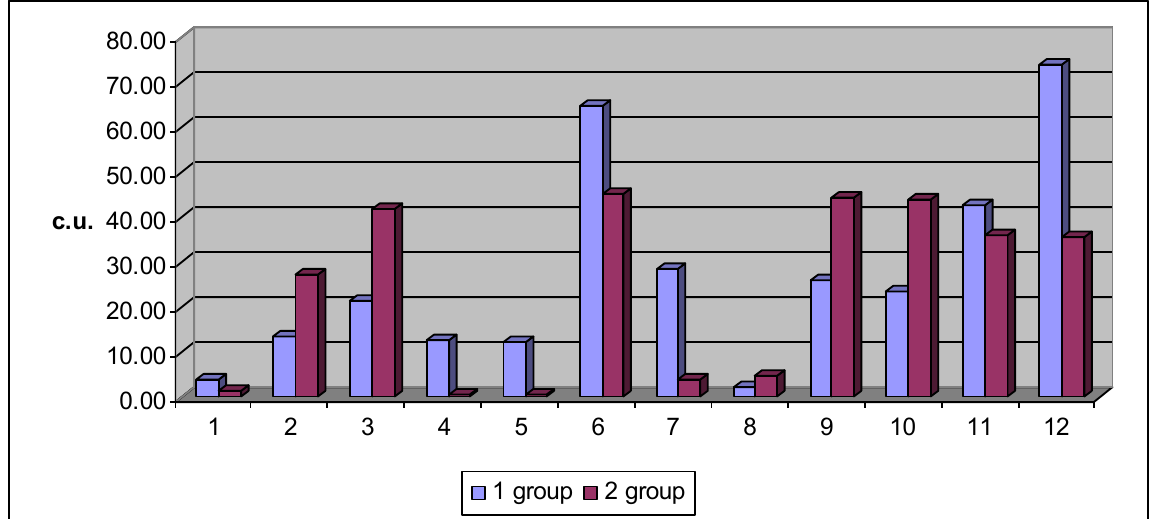
Fig. 1. System formation indicators in arm wrestler groups (conditional units). Notes. 1 - age, 2 - handgrip test of the right hand, 3 - handgrip test of the left hand, 4 - maximum handgrip frequency in pulsed mode with the left hand, 5 - maximum handgrip frequency in pulsed mode with the right hand, 6 - body mass, 7 - body length, 8 - specific gravity of adipose tissue, 9 - specific gravity of visceral fat, 10 - specific gravity of muscle tissue, 11 - body mass index, 12 - basal metabolism